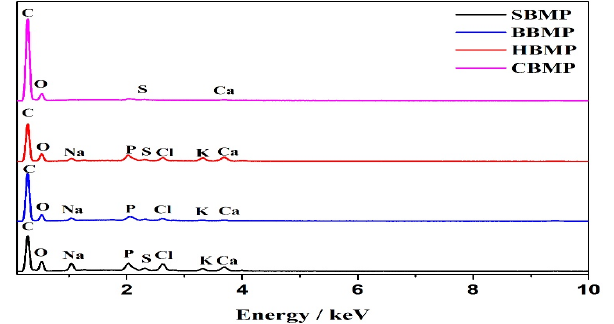
Figure 4. EDX of four kinds BMP.